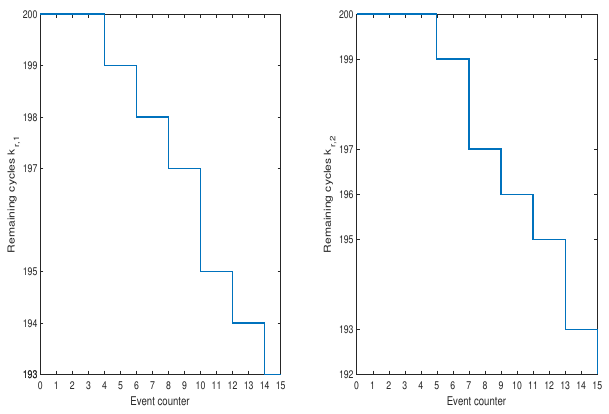
Figure 17. Scenario 2: SOH of AGVs expressed by the remaining cycles k f , i .